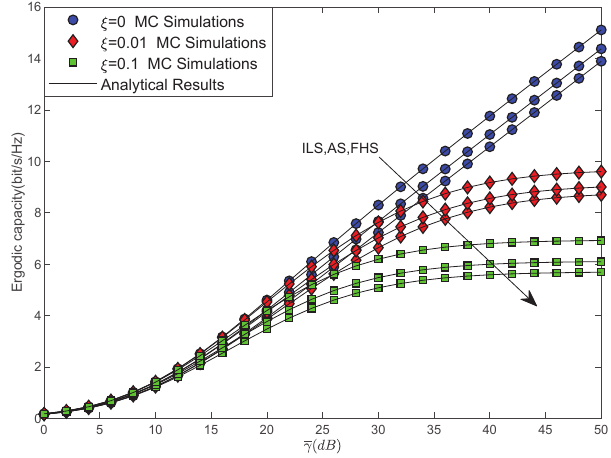
Figure 4. EC versus ¯ γ for different imperfect SIC